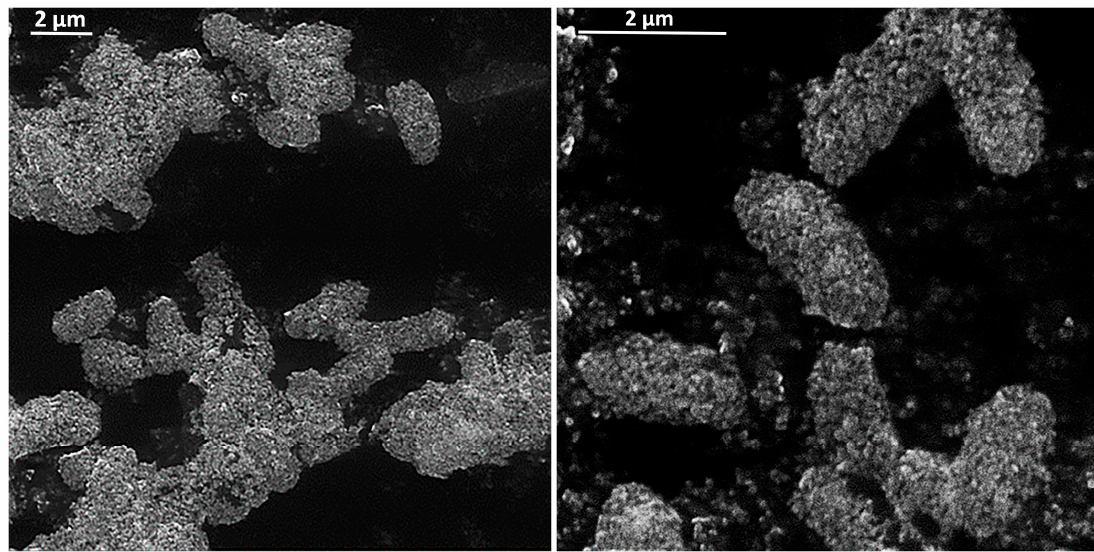
Figure 3. Electrostatic and Van der Waals interactions between magnetite (Fe 3 O 4 ) NPs and bacterial cells: NPs adhere to the cell wall and form a magnetite shell. The images obtained by scanning electron microscopy (Tescan VEGA 3, Brno, Czech Republic).